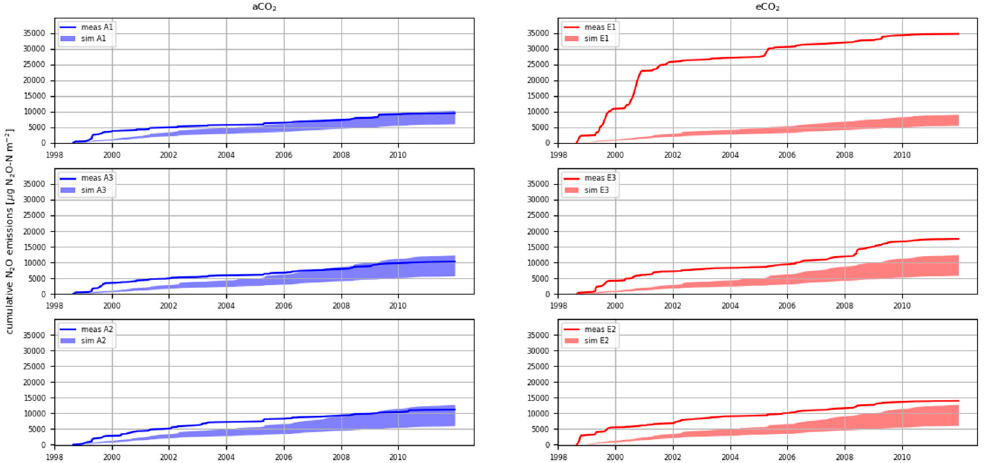
Figure 4. Cumulative measured and simulated N 2 O emissions from ambient (aCO 2 ) and elevated CO 2 (eCO 2 ) FACE rings. Plots are arranged according to increasing soil moisture from driest (top, A1 / E1) to medium (middle, A3 / E3) and wettest (bottom, A2 / E2) rings. Measurements are depicted in lines, and confidence intervals of simulations are depicted as colored areas.